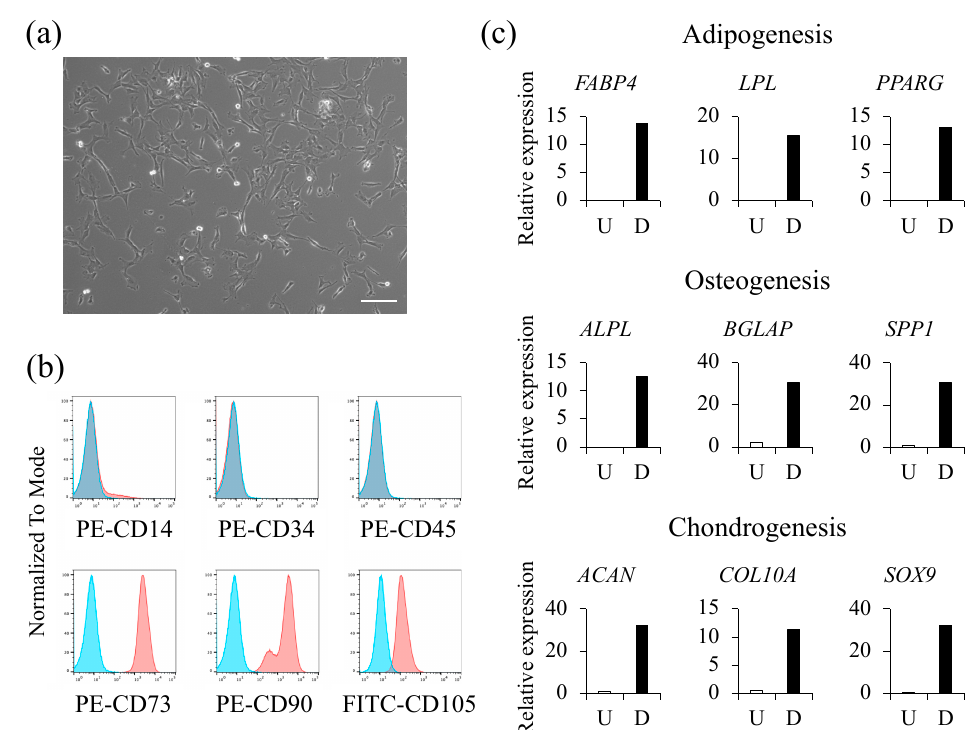
Figure 1. Characteristics of human amniotic fluid stem cells (hAFSCs). ( a ) A bright-field image shows the morphology of hAFSCs in culture (scale bar = 200 µ m); ( b ) Surface CD markers of hAFSCs were analyzed by flow cytometry; ( c ) hAFSCs were cultured using adipogenic, osteogenic, or chondrogenic differentiation media. To assess the differentiation potential, the expression of genes characteristic of each differentiated cell was assessed using RT-qPCR. U, undifferentiated; D, differenti- ated.